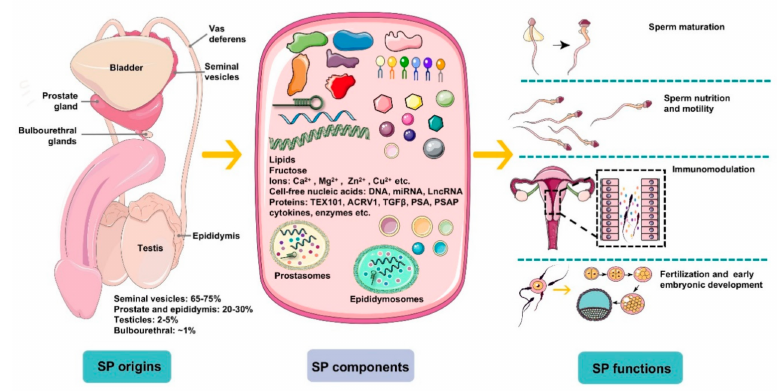
Figure 1. An overview of the origins, components, and main functions of seminal plasma (SP). Seminal plasma makes up more than 95% of the human ejaculate volume, whereas testicular secretions containing spermatozoa compose about 2–5% of semen. Seminal plasma is mainly derived from seminal vesicles, the prostate and epididymis, which produce ~65–75% and ~20–30% of the volume of semen, respectively, with a small proportion generated by bulbourethral glands (~1%). SP is composed of a complicated set of heterogeneous molecular structures, including proteins (enzymes,